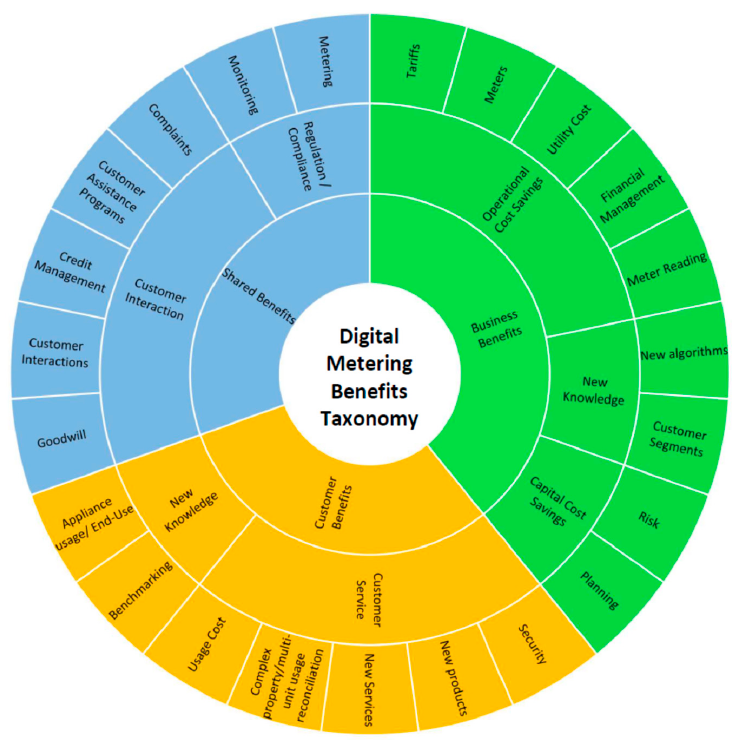
Figure 2. The taxonomy of digital meter benefits by beneficiary group.